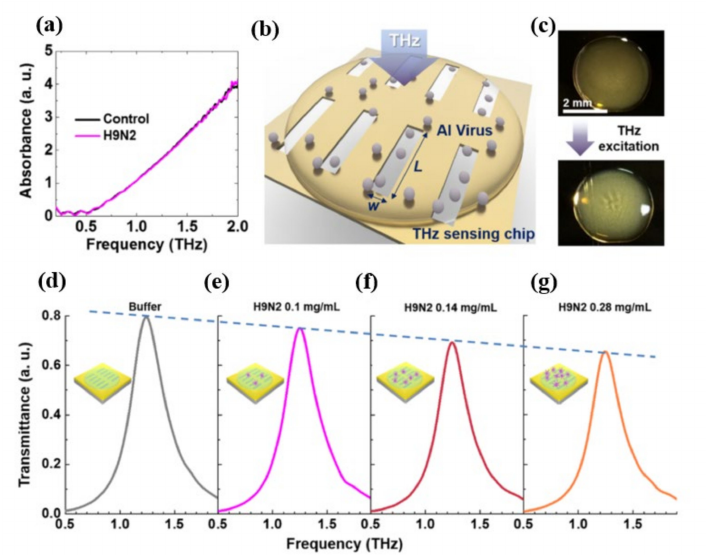
Figure 5. ( a ) Absorption spectra for pallet types of viruses included a protein sample (H9N2) and a control sample (without virus). ( b ) A conceptual schematic of THz detection of virus samples. ( c ) Optical images of dropped virus solutions onto the multi-resonance nano-antenna array before (top) and after (down) THz excitation. ( d – g ) Normalized THz spectra for various concentrations (0, 1, 0.14, 0.28 mg/mL) of H9N2 virus in buffer solution. Reprinted with permission from [49]. Copyright 2017